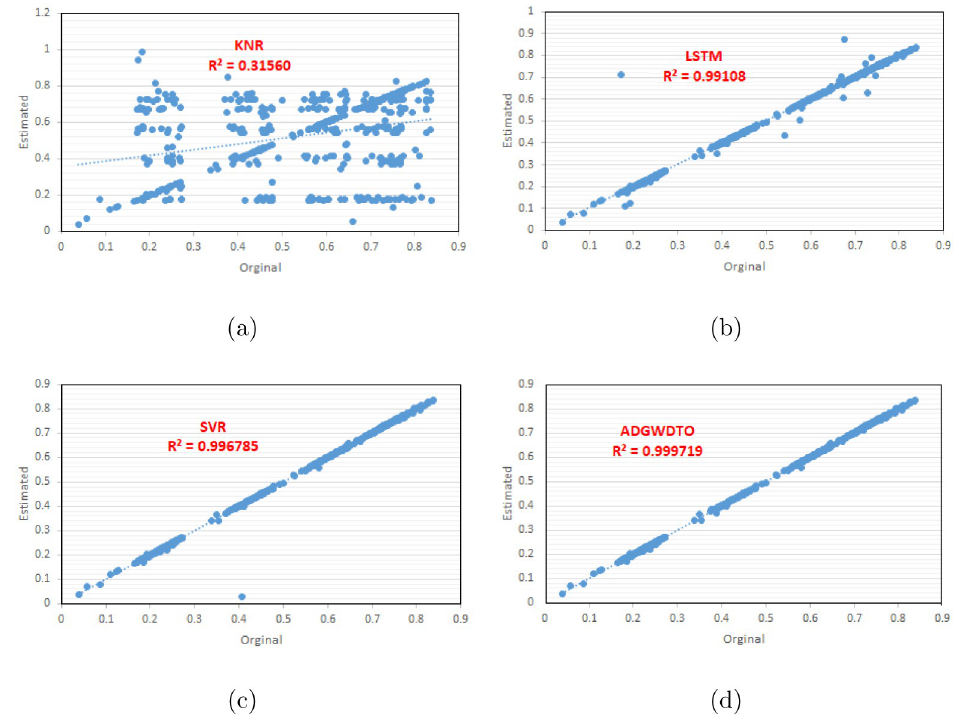
Fig 3. Fitting the prediction values resulting by KNR, LSTM, SVR, and the proposed ADGWDTO.